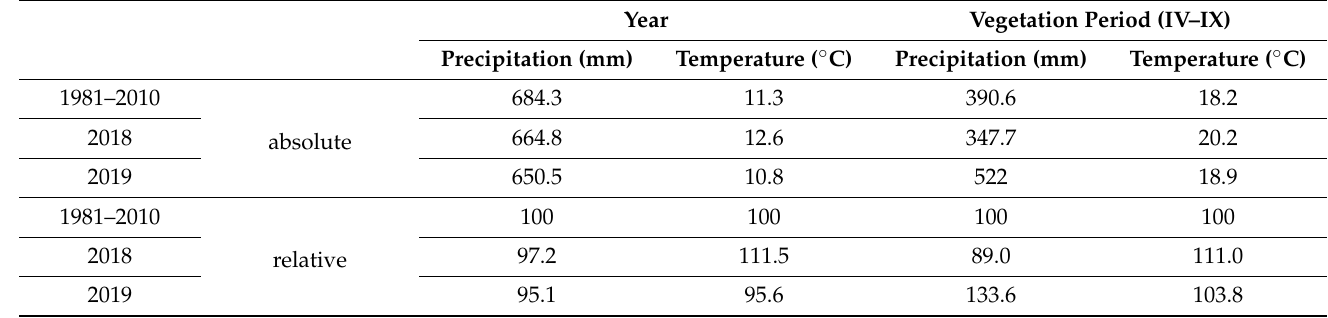
Table 2. Average absolute temperatures and precipitation at the investigated area and relative deviation from the multi-year average